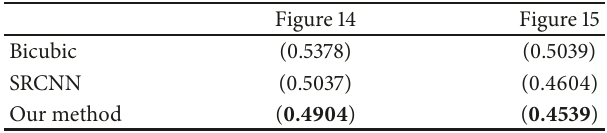
Table 3: The objective comparison (BRISQUE) of actual incipient fault by three methods. Bold indicates the best